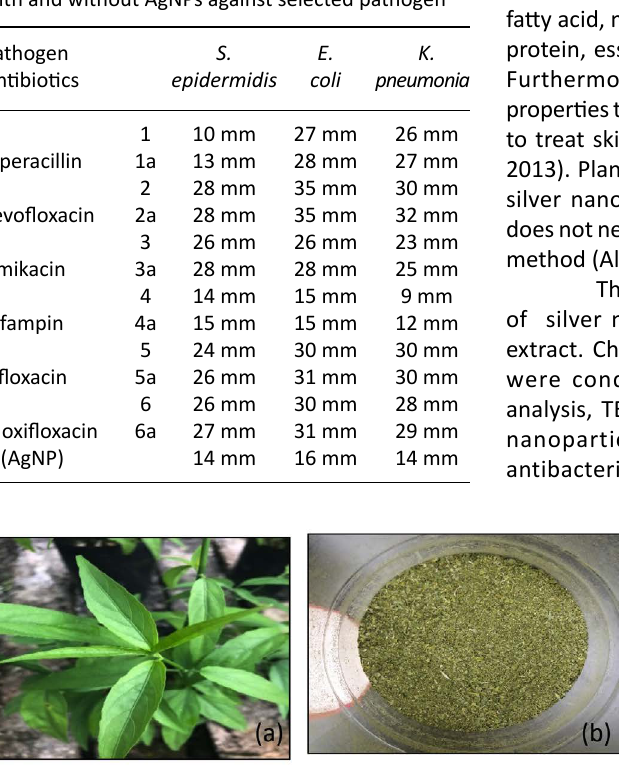
Fig. 1. (a) C. nutans plant (b) grinded leaves of C. nutans (c) silver nanoparticles